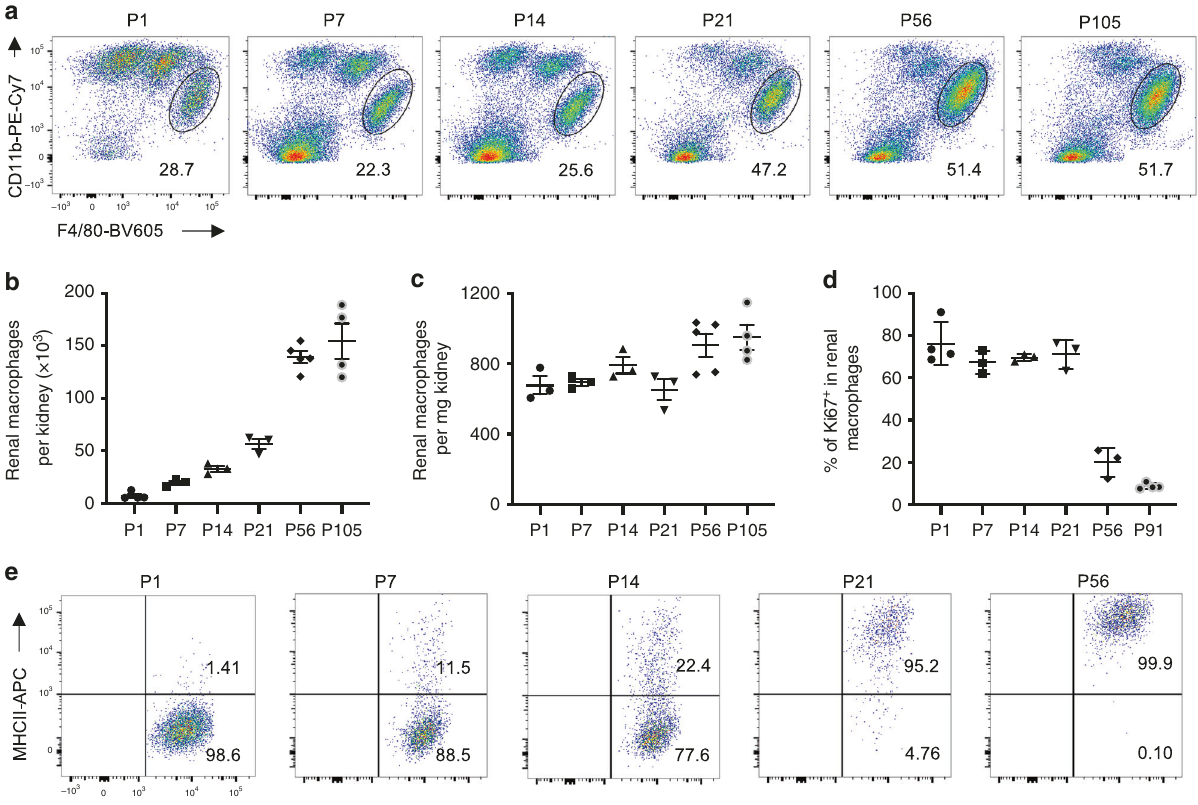
Fig. 1 Postnatal expansion and maturation of RMs parallel renal growth. a Representative fl ow cytometry plots show the percentage of CD11b + F4/80 high (cycled area) RMs among CD45 + leukocytes at different ages. b , c Absolute CD11b + F4/80 high RMs cell counts ( b ) and density of RMs (counts/kidney weight) ( c ) at different ages. Data are pooled from two independent experiments ( b : n = 3 mice for P7,14,21; n = 4 mice for P1,105; n = 5 mice for P56. c : n = 3 mice for P1,7,14,21; n = 4 mice for P105; n = 5 mice for P56). d Intracellular staining of Ki67 (proliferative marker) in RMs. Ki67 was detected after surface staining of RMs and the percentage of Ki67 + RMs at different ages is quanti fi ed. Data are pooled from two independent experiments ( n = 4 mice for P1,91; n = 3 mice for P7,14,21,56). e Representative fl ow cytometry plots show major histocompatibility II (MHCII) and CD11b expression on RMs over time at P1, 7, 14, 21, and 56. All data are presented as mean ± s.e.m. Source data are provided as a Source Data fi